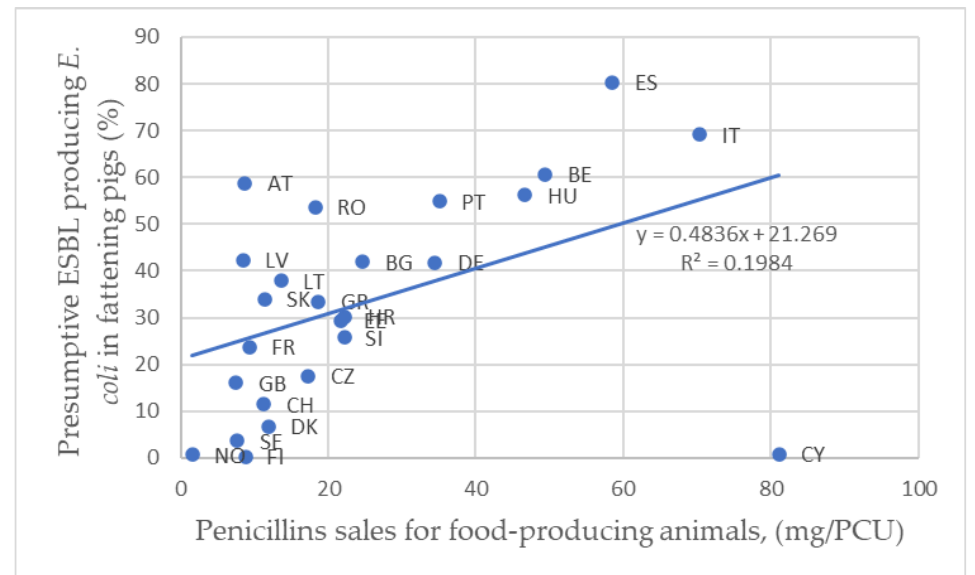
Figure 2. Correlation between presumptive ESBL E. coli prevalence in fattening pigs and sales of penicillins in 2017. Country codes used according to ISO 3166.